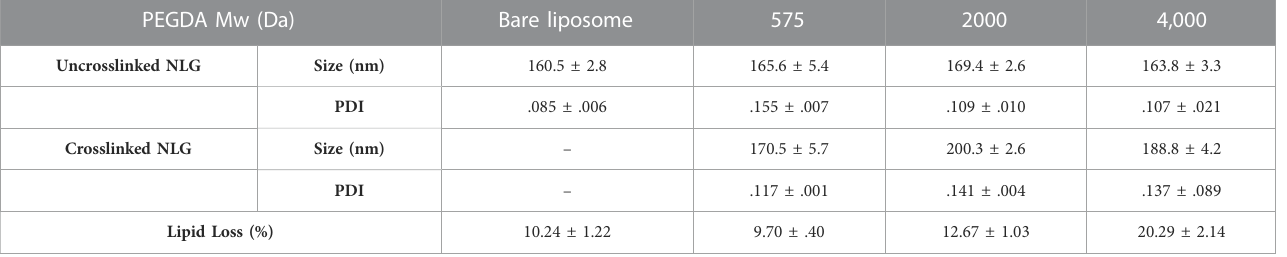
TABLE 1 Characterisation of Bare Liposome, uncrosslinked PEGDA NLG and crosslinked PEGDA NLG (n = 3). PEGDA Mw (Da)